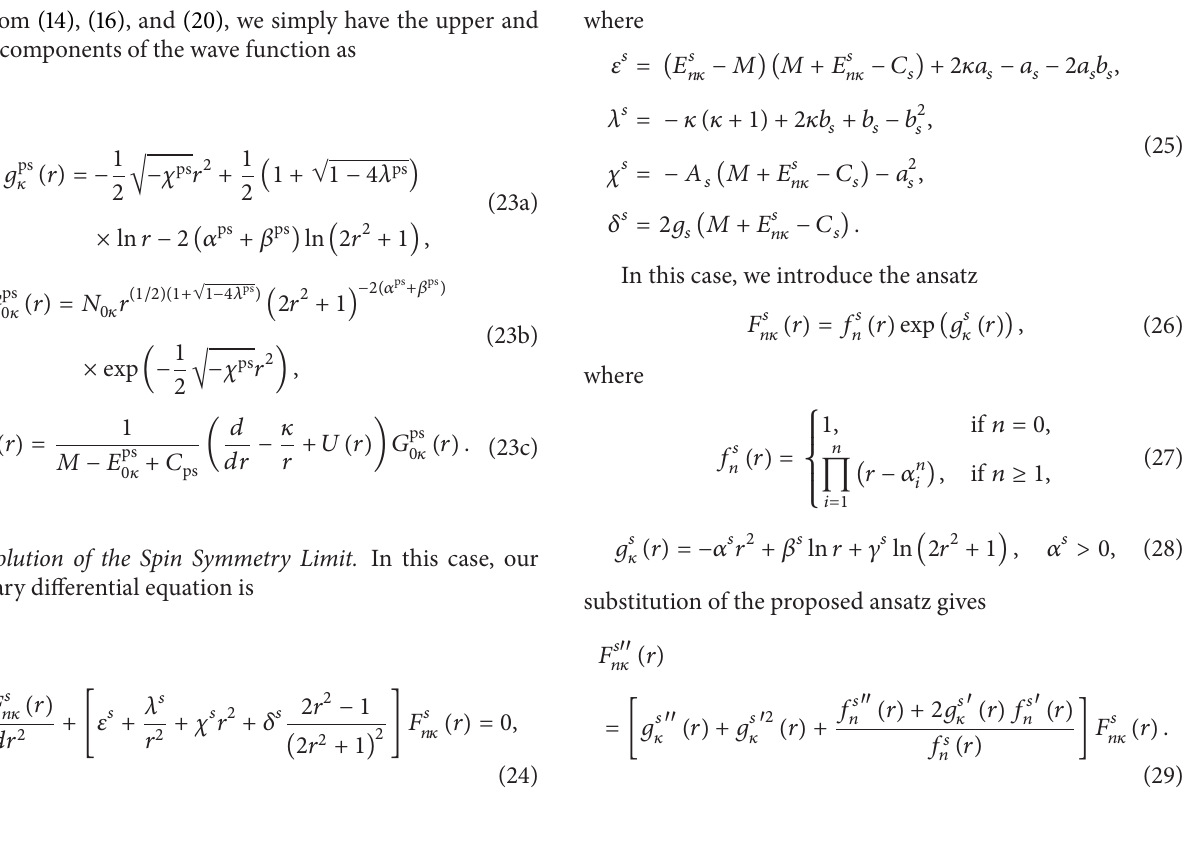
= −0.02 , 𝑏 = 0.01 , 𝑀 = 0.5 fm −1 , and 𝐶 ps ps